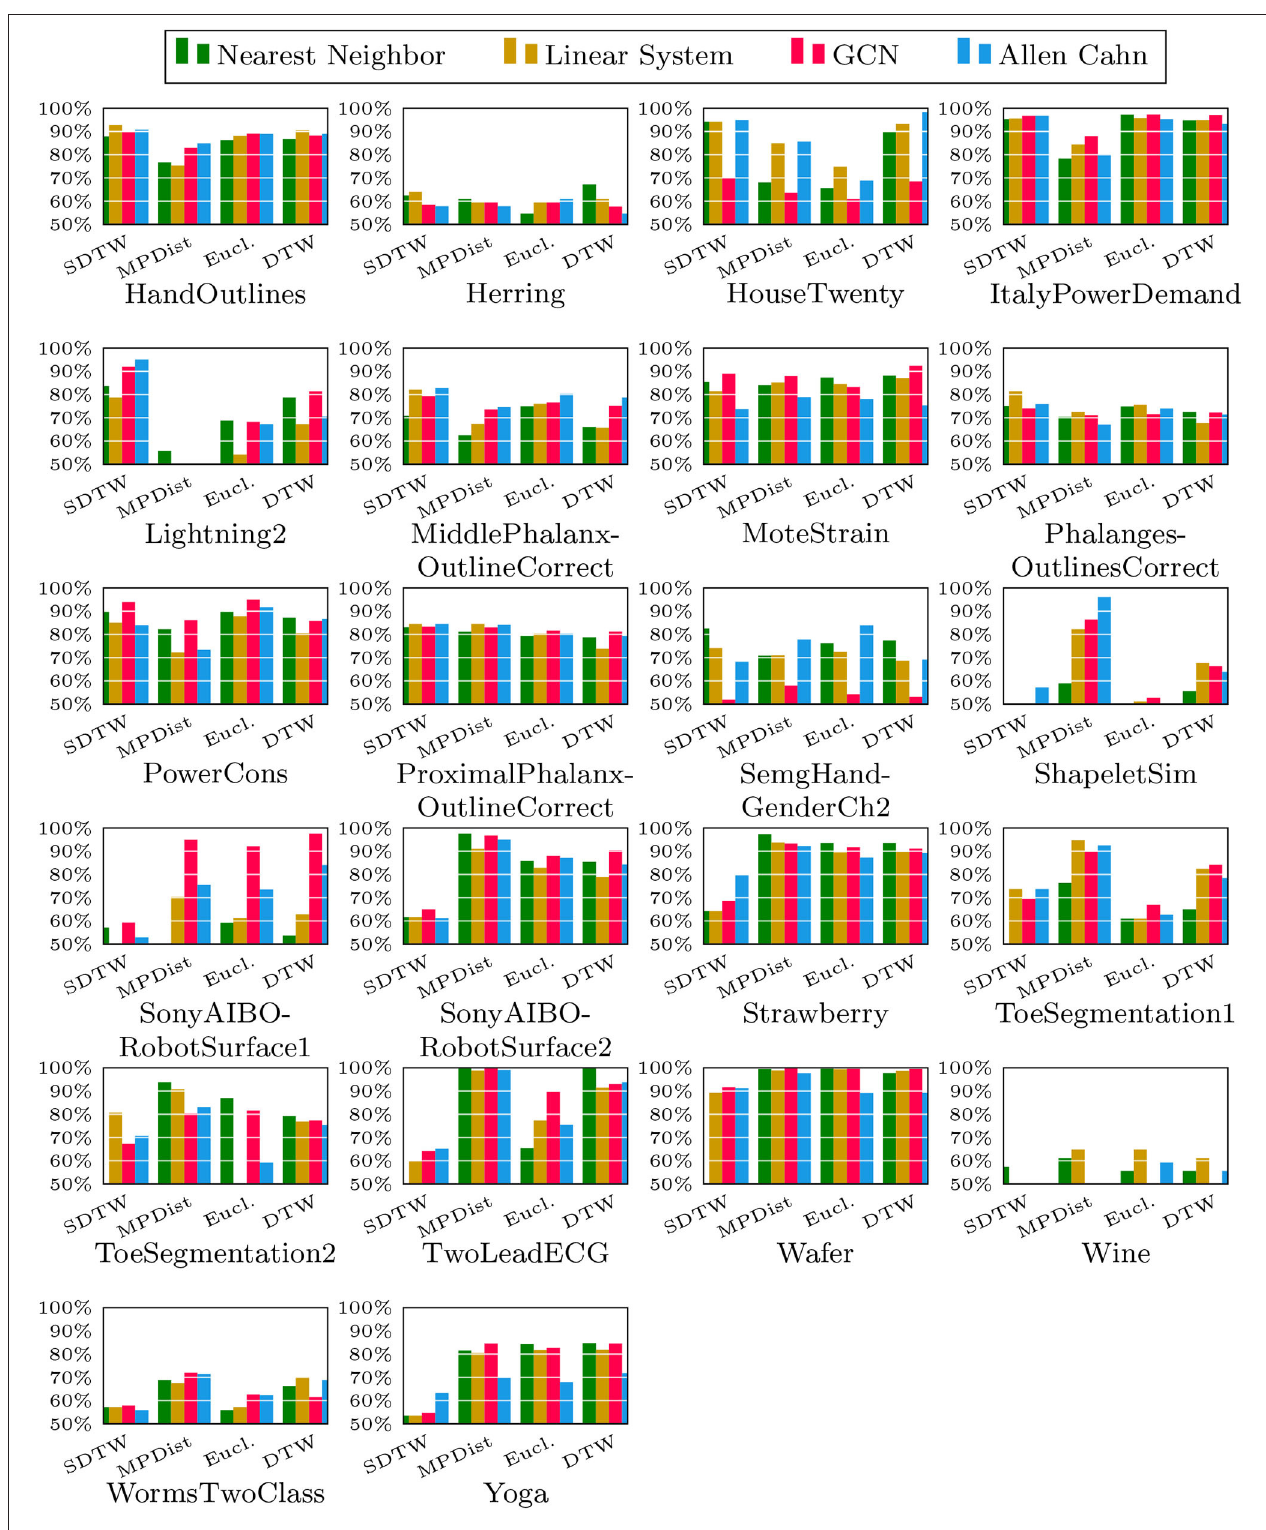
FIGURE 7 | Comparison of the proposed methods using various distance measures for a variety of time series data.